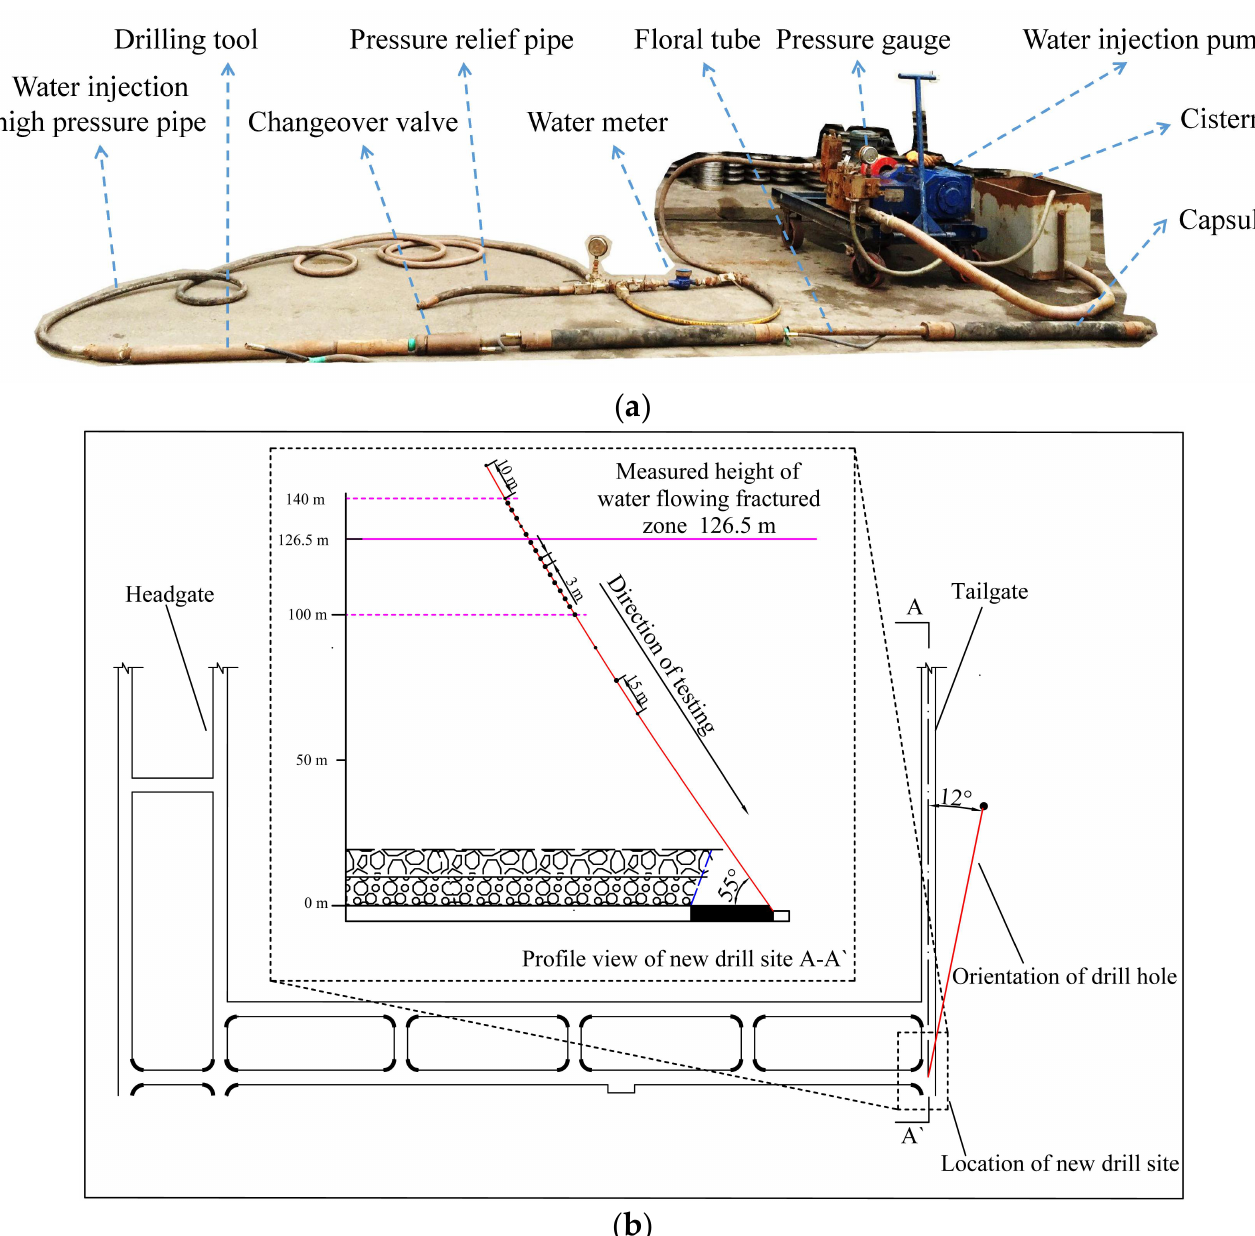
Figure 9. ( a ) Schematic diagram of experiment device. ( b ) T1 borehole orientation and measuring point layout.